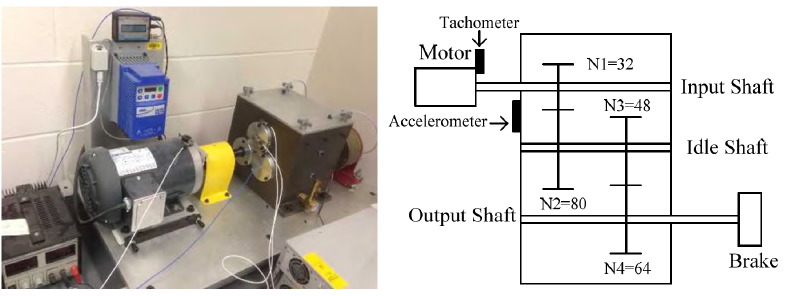
Figure 11. Two-stage gearbox picture ( left ) and kinematic diagram ( right )